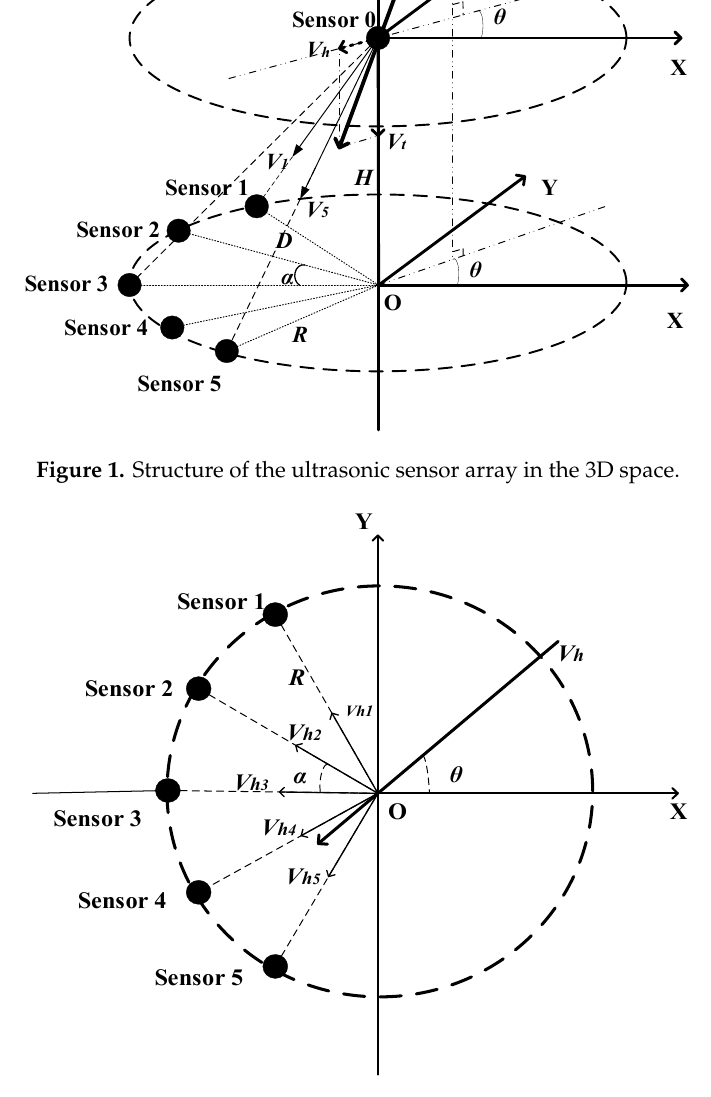
Figure 2. Structure of the receiving ultrasonic sensors on the horizontal plane.